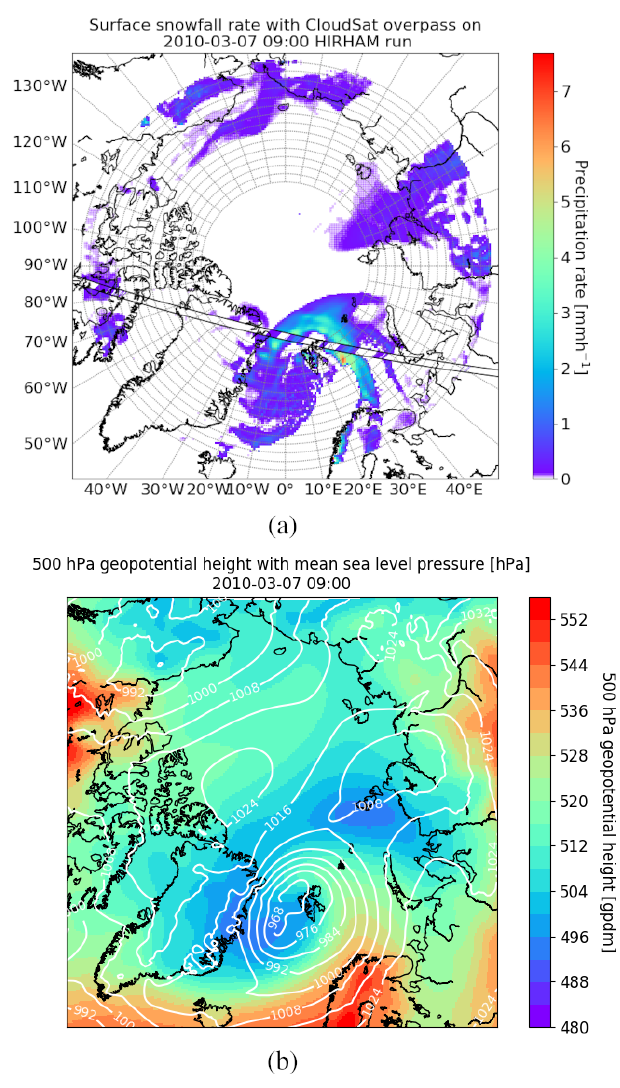
Figure 2. Case study on 7 March 2010. (a) The overpass of Cloud- Sat, where the surface snowfall rate (mmh − 1 ) taken from the clos- est model run of HIRHAM5 is shown underneath and the over- pass is colored with surface snowfall rate values of the 2C-SNOW- PROFILE product. Panel (b) shows HIRHAM5 500hPa geopoten- tial height with mean sea level pressure plotted with contour